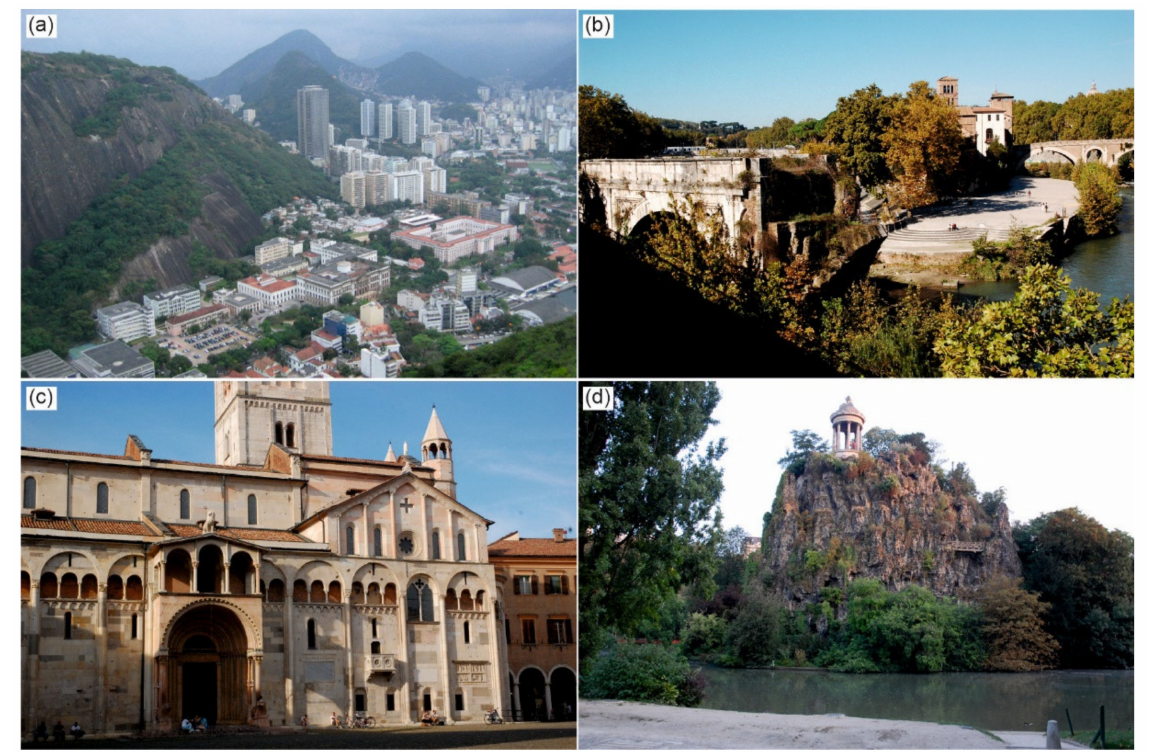
Figure 2. Examples of urban geoheritage of different kinds and scale. ( a ) the city of Rio de Janeiro developed amidst large granite-gneiss domes, ( b ) Tiberina Island in the centre of Rome is a much altered natural gravel bar of the river Tiber, ( c ) a romanesque cathedral in Modena, Italy, built of various building stones, ( d ) Parc des Buttes-Chaumont—an old gypsum quarry in the centre of Paris, converted into a municipal park (all photographs by the